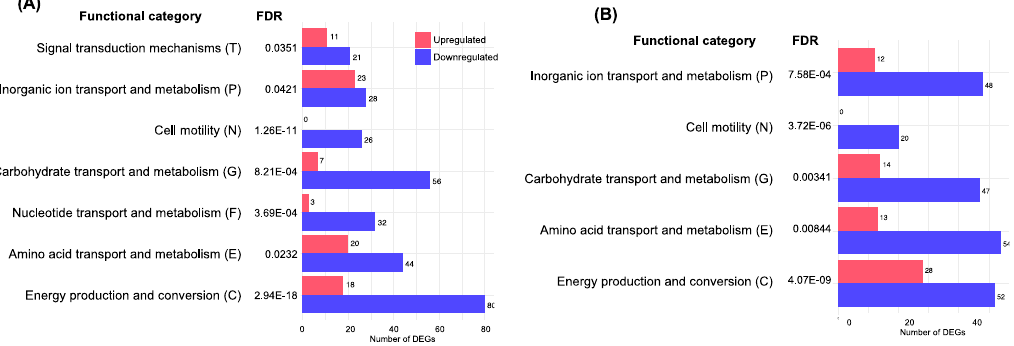
Figure 4. Functional enrichment analysis with DEGs. ( A ) Comparison of DEGs from phenol and non-treated samples. ( B ) Comparison of DEGs from formalin and non-treated samples. Numbers next to the horizontal bar indicate the number of DEGs analyzed.